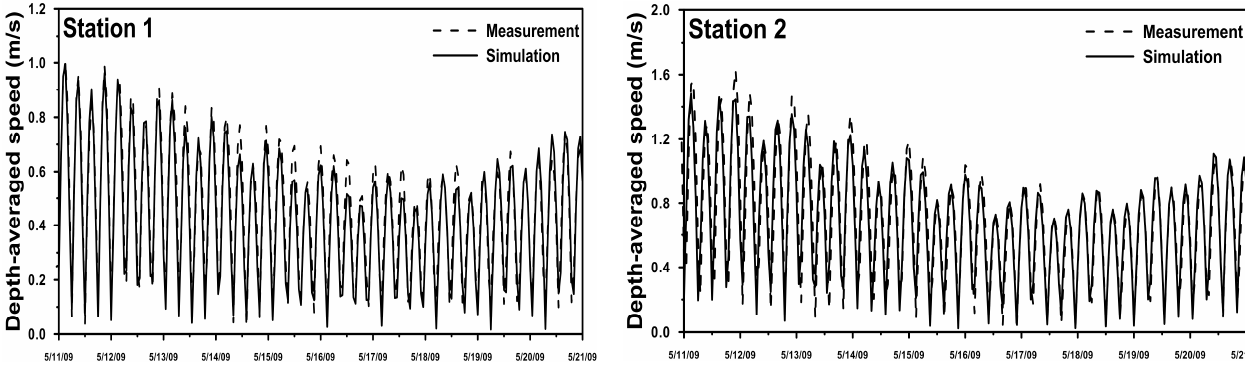
Figure 4. Comparisons between simulated and observed depth-averaged tidal current speeds at station 1 and station 2.